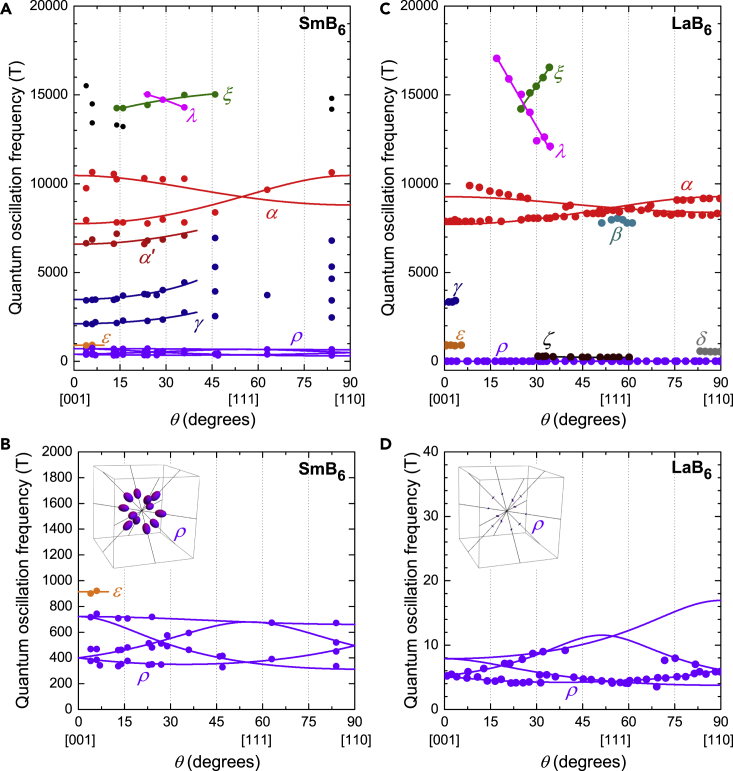
Comparison of Angular Dependence of Quantum Oscillation Frequencies in SmB6 and LaB6Angular dependence of the quantum oscillation frequencies in the [001]-[111]-[110] rotation plane measured for floating zone-grown single crystals of (A and B) SmB6 from Tan et al. (2015), and (C and D) LaB6 from Ōnuki et al. (1989); Ishizawa et al. (1977), both in good agreement with the angular dependence of a three-dimensional ellipsoidal Fermi surface characteristic of metallic hexaborides. (A) and (C) show the similarity of the higher frequency branches, particularly the main α branches, which correspond to ≈50% of the Brillouin zone volume when the three-fold degeneracy is included, while (B) and (D) compare the lower frequency ρ branches, which give rise to the most prominent oscillations, together with illustration of the corresponding Fermi surface sections. Solid lines are based on a three-dimensional ellipsoidal Fermi surface model. For the α branches of SmB6, we obtain a minimum frequency of Fmin = 7580 T and a ratio of the semi-principal axes of 1.4. For the α branches of LaB6 we obtain Fmin = 7710 T, and a ratio of the semi-principal axes of 1.2. Fitting to the ρ branches of SmB6 we find a minimum frequency of Fmin = 313 T, and the ratios of the two longer semi-principal axes to the shortest axis to be 2.3 and 1.1. In the case of LaB6, we find Fmin = 3.7 T and ratios of 3.5 and 1.5.